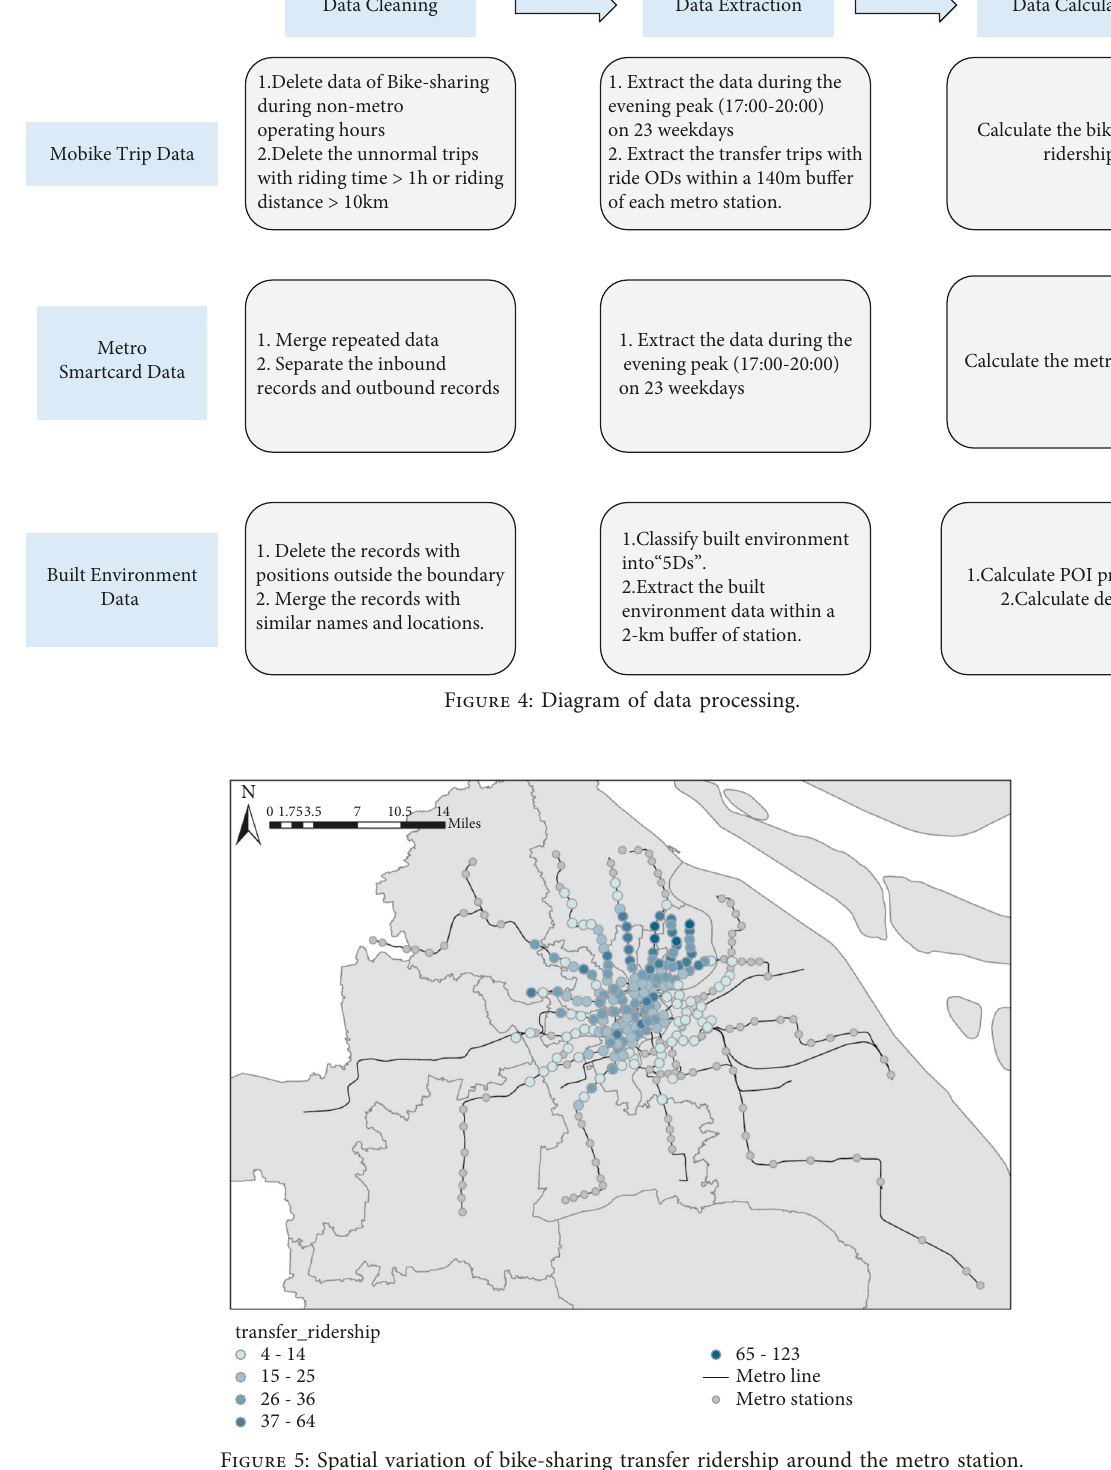
Figure 5: Spatial variation of bike-sharing transfer ridership around the metro station.